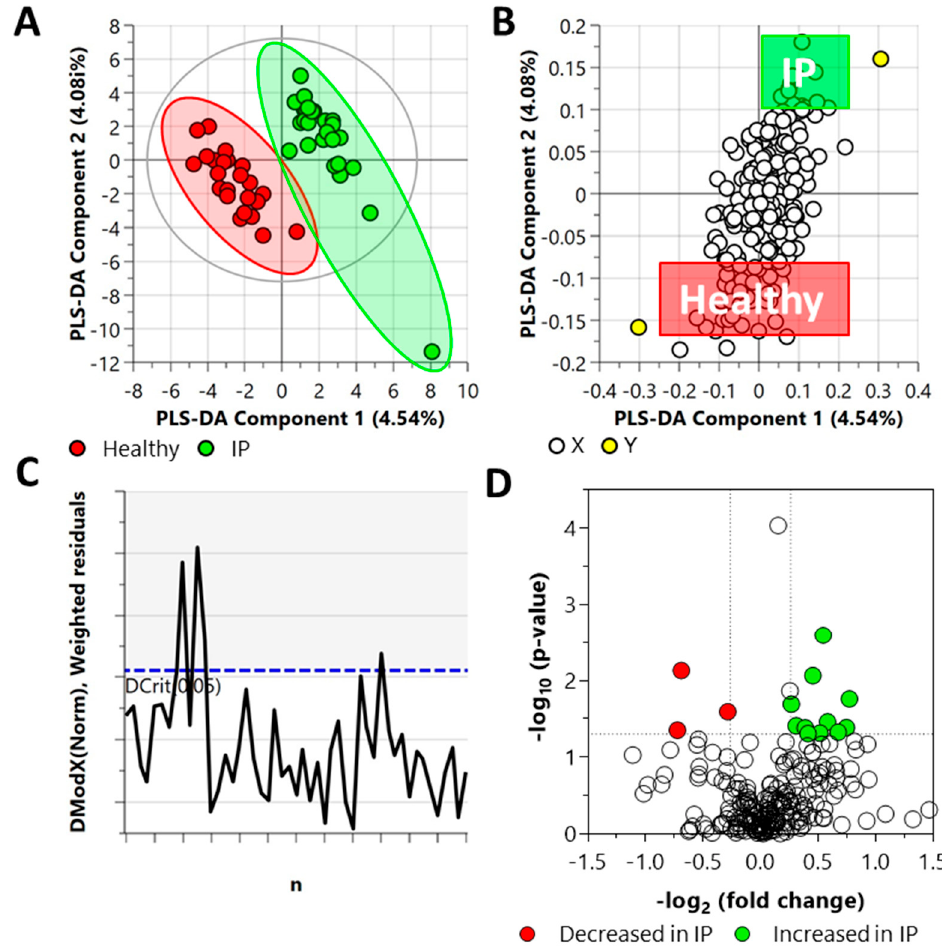
Figure 2. Distinct metabolic profiles of plasma samples in increased IP subjects compared with the healthy subjects, as revealed by the Partial Least Square Discriminant Analysis (PLS-DA) (panels A – C ) and fold change (FC) analysis (panel D ). ( A ) PLS-DA scatter plot, ( B ) PLS-DA loading plot, ( C ) distance of observation plot, and ( D ) volcano plot of plasma samples collected from study participants. R 2 X (cum) = 0.0862, R 2 Y (cum) = 0.947, Q 2 = 0.372, DCrit (blue line in panel C ) = 1.222. Note: The ellipse presented in panel A represents Hotelling’s T2 confidence limit (95%). The colored circles in panel A represent each analyzed sample, while the yellow-colored circles in panel B indicate the average group position for each sample cluster, with the white circles representing the distribution of metabolite features between these groups. The colored circles in panel D represent significant metabolites in IP subjects compared with the healthy subjects .